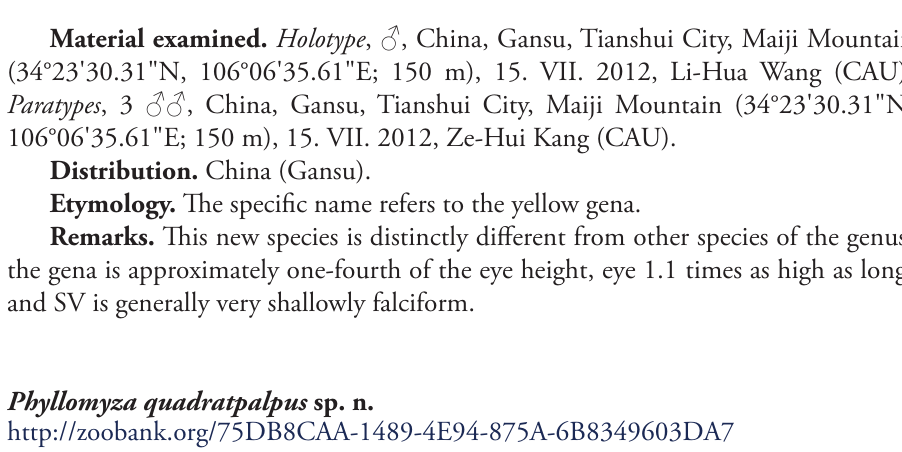
Diagnosis. Gena narrowed, approximately one-twelfth of eye height. Surstylus with upper blade of bifurcated tip extremely swollen, lower one slightly swollen and shorter than upper one.